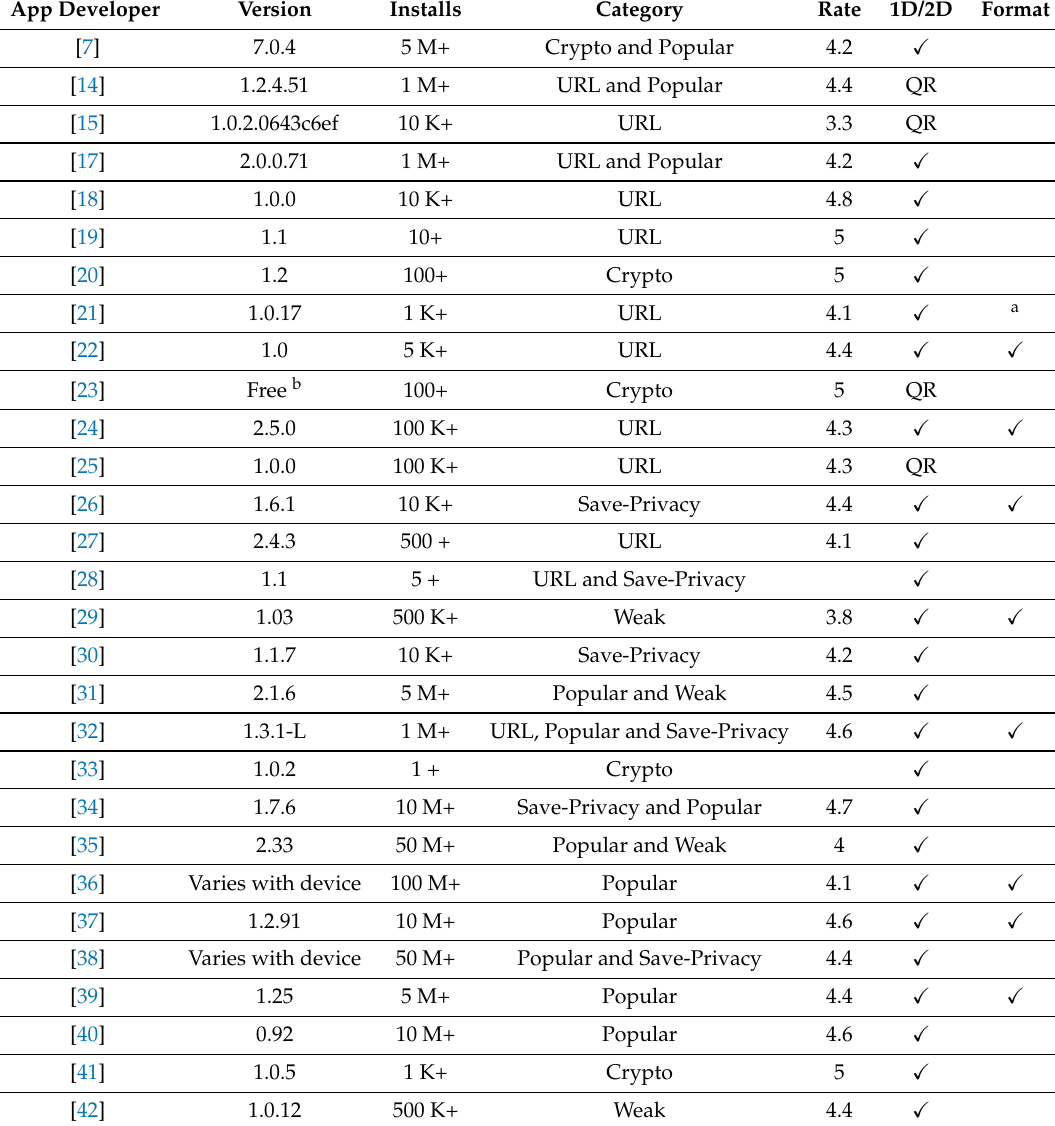
Table 1. Details of the Tested QR Code